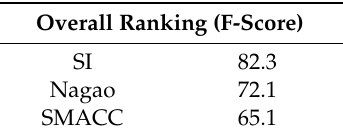
Table 9. Final rankings for F-score calculated from Method Mean in Table